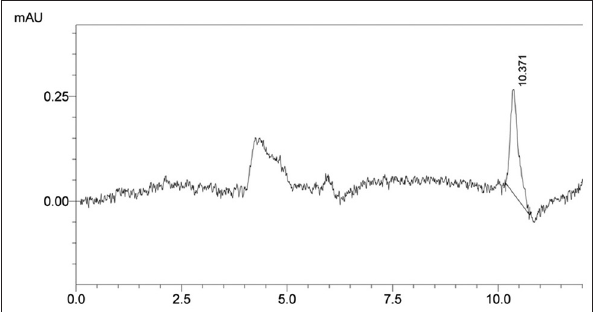
Figure-3: The lowest concentration aflatoxin B (0.05 µg/mL) in mobile phase.